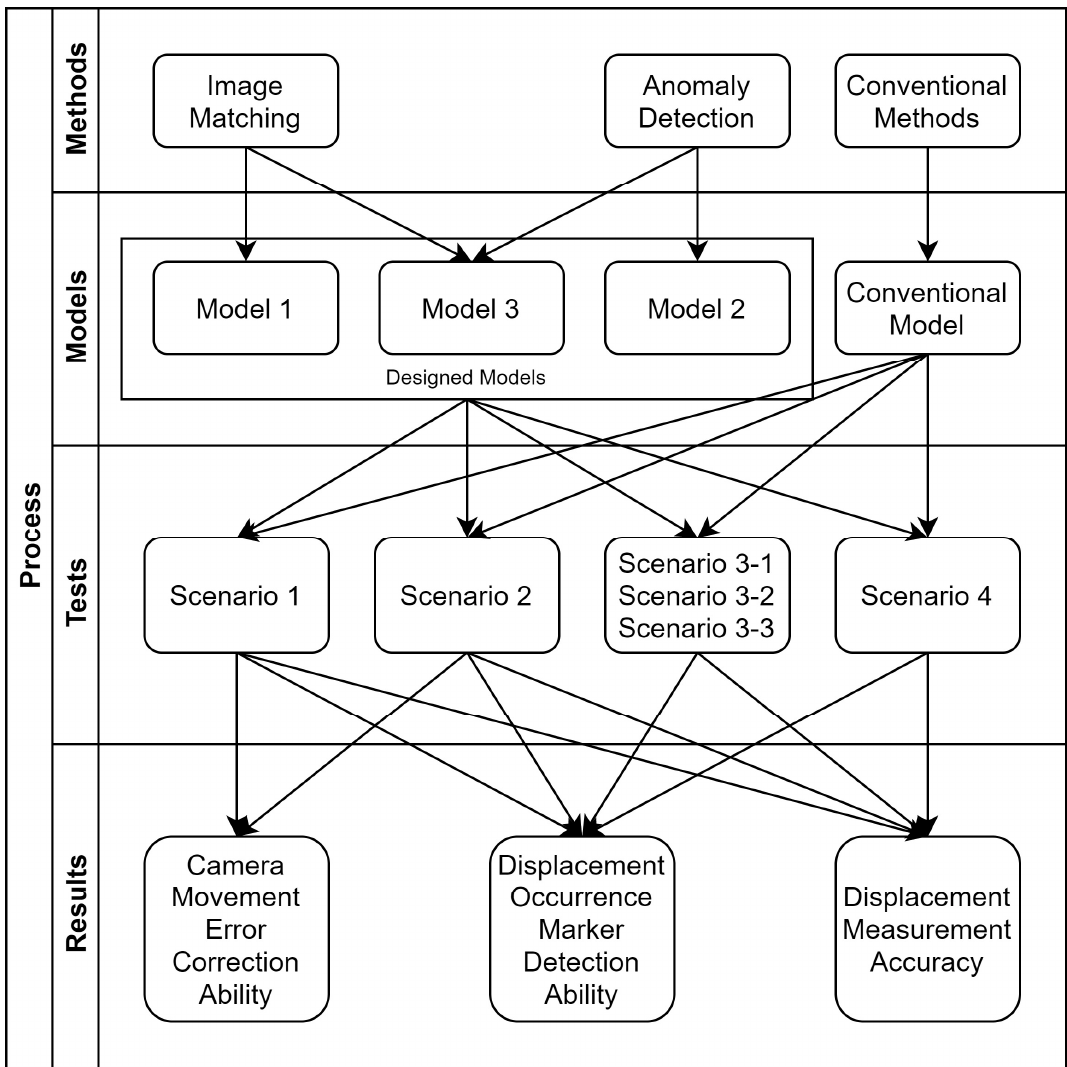
Figure 1. Research methodology.